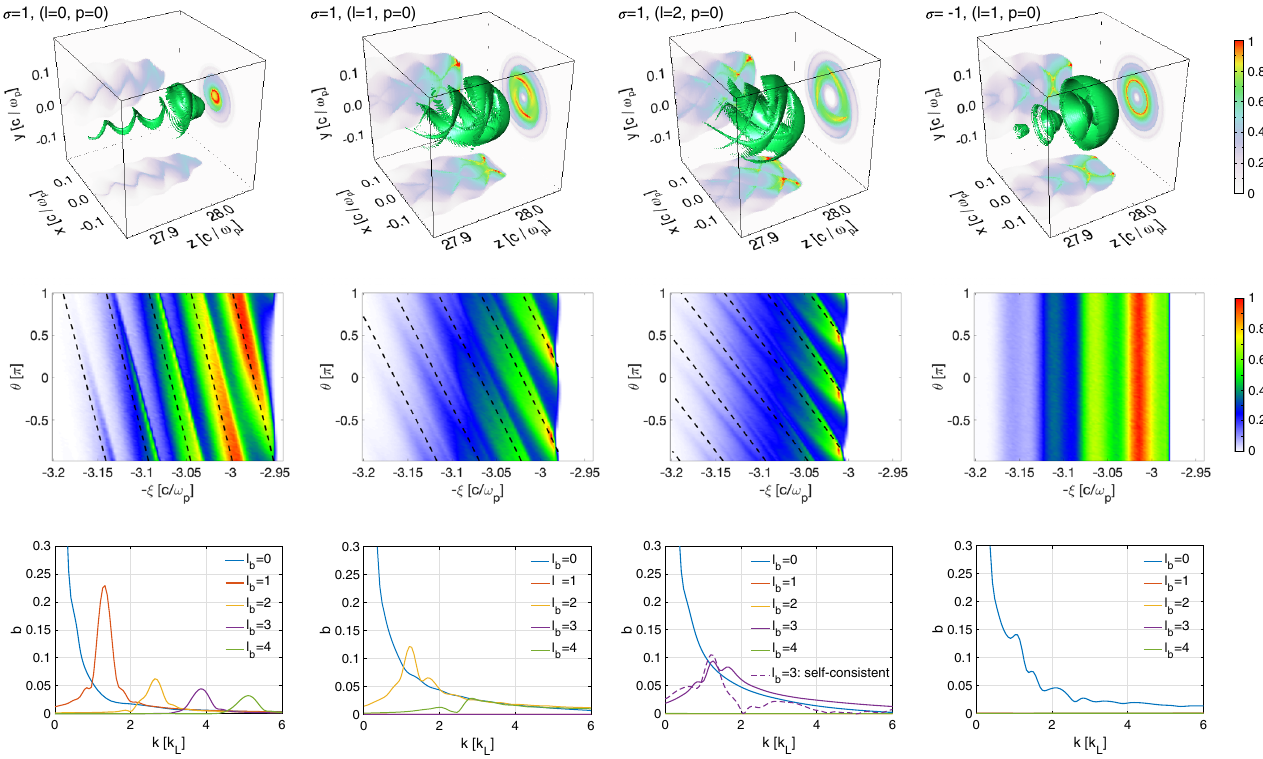
t ¼ 31 . First row: Isosurface of the electron density and its projections on each FIG. 1. The structures of the injected electrons at ω p plane. Second row: Normalized density distribution of the electrons in the θ − ξ plane. The black dashed lines represent the predications from Eq. (2). Third row: bunching